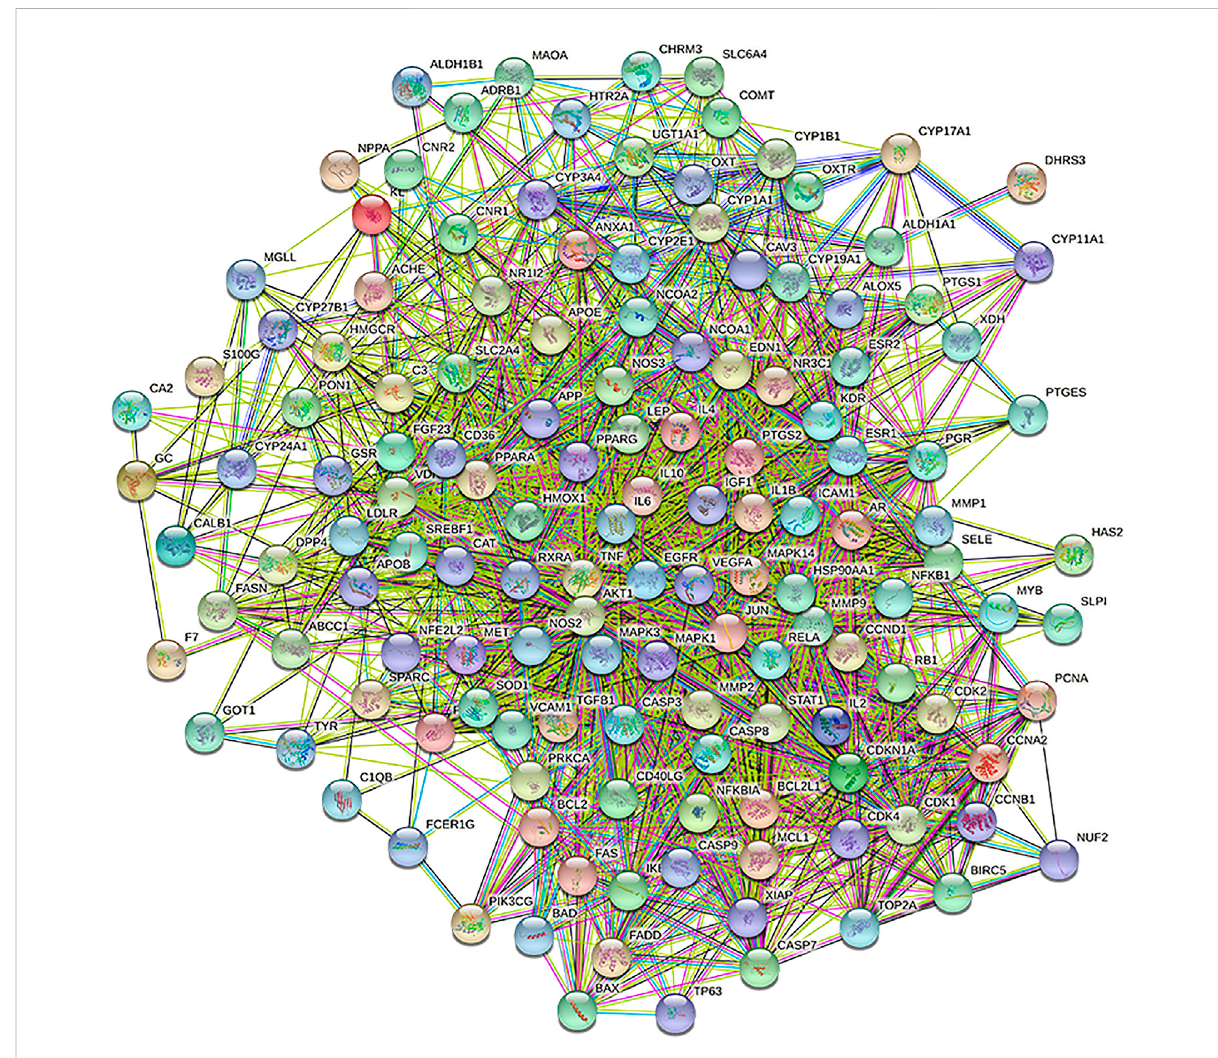
FIGURE 3 PPI network based on STRING